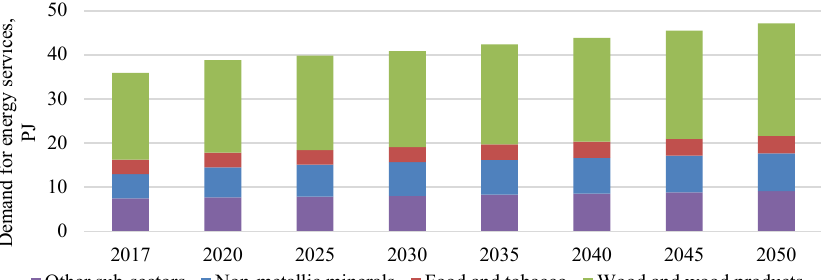
Fig. 2. Demand for energy services in the industry sector.